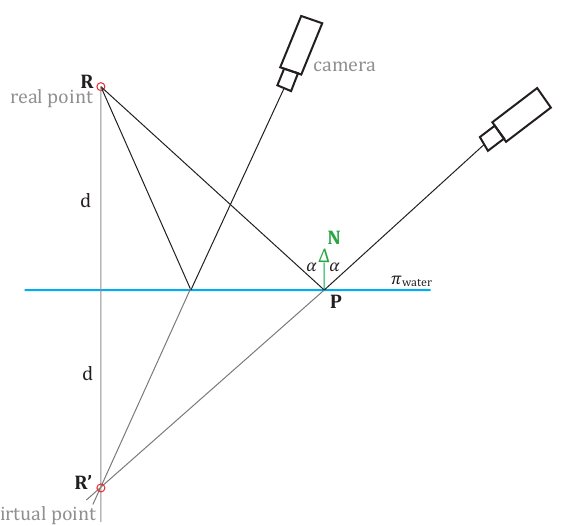
Figure 9. The imaging configuration taking place when deriving the control information. R represents the end-point of a linear lamp; R (cid:48) is its virtual location, at d distance behind the water plane π . The camera to real-point rays follow the law of reflection, i.e ., the incident and reflecting rays form equal angles with the plane normal N